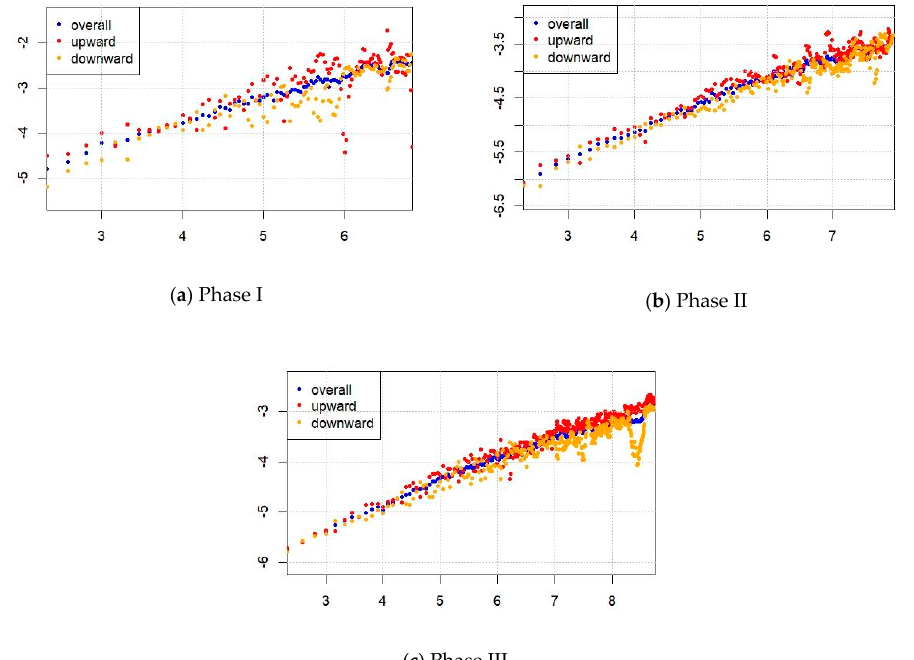
Figure 3. Asymmetric MF-DFA functions F 2 ( n ) versus the time scale n in a log–log plot of the returns. ( a ) (cid:1832) (cid:2870) ((cid:1866)) of Phase I; ( b ) (cid:1832) (cid:2870) ((cid:1866)) of Phase II; ( c ) (cid:1832) (cid:2870) ((cid:1866)) of Phase III.